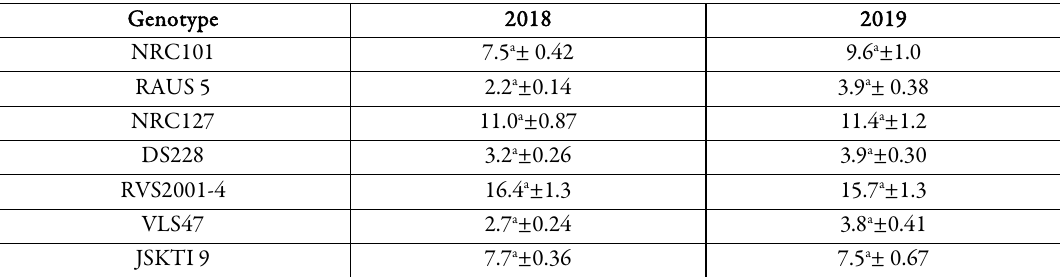
Table 3. BBI concentration (mg/g defatted soy flour) of selected soybean genotypes across different growing